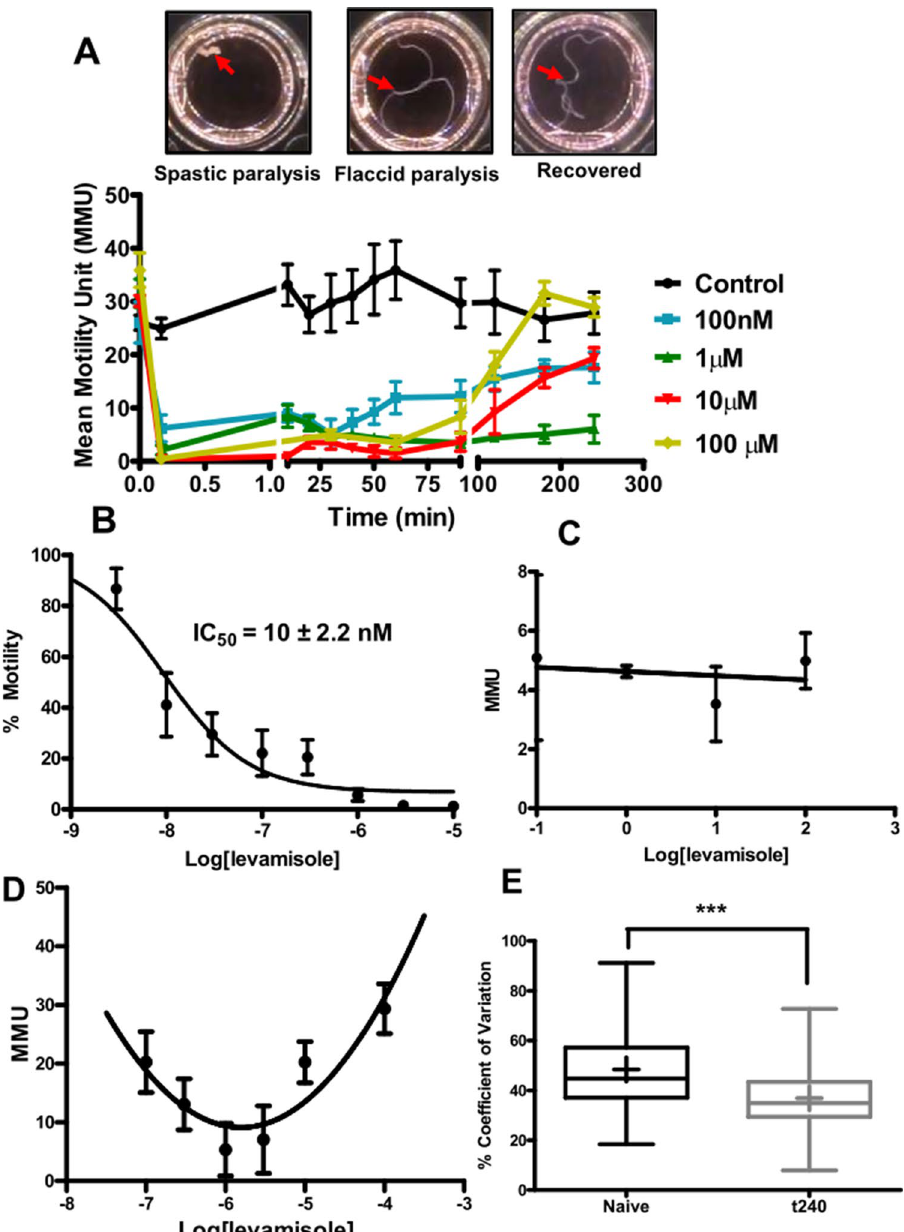
Figure 1. Levamisole is highly potent in paralyzing adult B. malayi females, but the worms undergo desensitization within 4 h. ( A ) Images of the time-dependent stages: (i) spastic paralysis as the worms contracted into a ball within 1 min after application of levamisole; (ii) flaccid paralysis as the worms gradually relaxed over the next 15–30 min but did not move and; (iii) the habituation and recovery phase as motility returned over the next 120–180 min. ( B ) Concentration–response analysis of adult B. malayi females treated with various concentrations of levamisole. Motility was measured 30 s post levamisole treatment. IC 50 = 10 ± 2.2 nM; n = 8 per concentration over two biological replicate studies. ( C ) Concentration–response analysis of B. malayi adult females treated with various concentrations of levamisole. Mean motility unit (MMU) values were taken at the 30 min time point post levamisole treatment; n = 12 worms per concentration over three biological replicate studies. ( D ) Non-linear concentration-MMU-response analysis of B. malayi adult females treated with various concentrations of levamisole T 240-min time point post levamisole treatment; n = 12 worms per concentration over three biological replicate studies. A 2nd order binomial was fitted (r 2 , 0.64) to illustrate the U-shaped relationship was better than a linear fit (low r 2 , 0.24). ( E ) Percent co-efficient of variation in naïve and recovered worms at t240; n = 60 over 15 biological replicate studies. Student’s t-test was performed for statistical analysis and p < 0.001 was statistically significant as indicated by